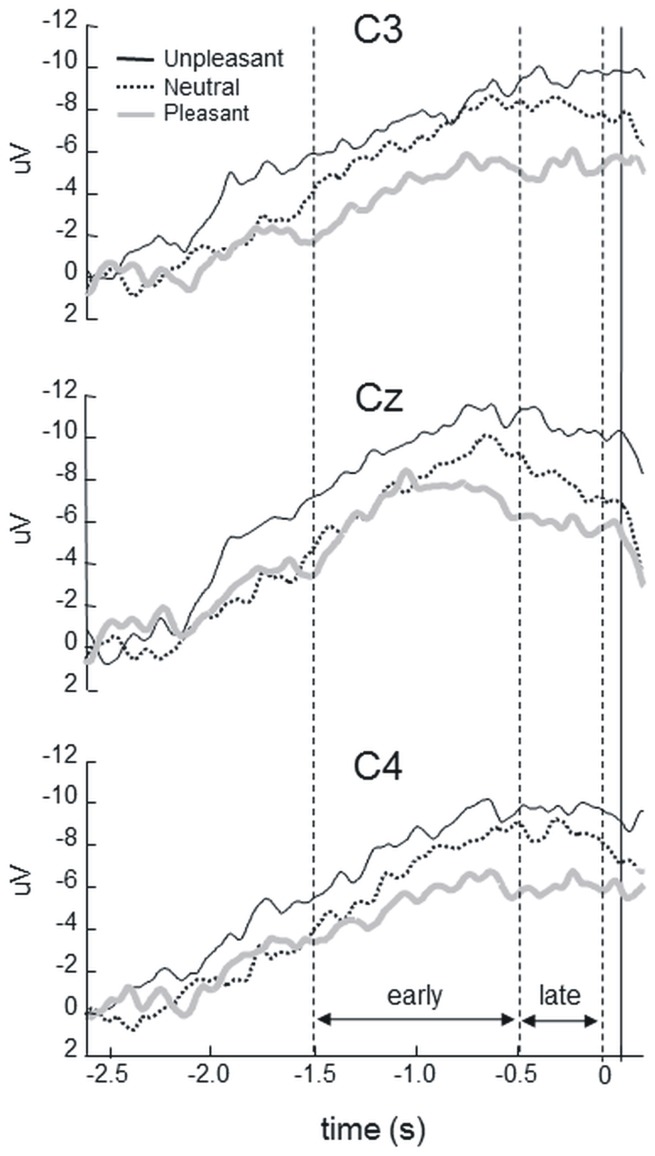
Mean average of readiness potential amplitudes preceding the grasping of pleasant, unpleasant and neutral stimuli for each analyzed channel (C3, CZ and C4).The mean readiness potential amplitude found for unpleasant stimulus was higher and that for pleasant stimuli lower relative to the observed for neutral stimuli.